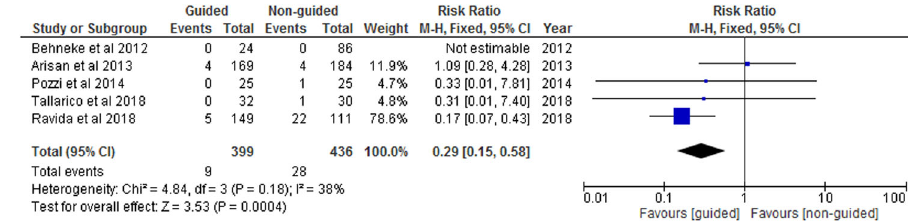
Fig. 2 Forest Plot. Forest plot comparing the “ guided ” group versus “ non-guided ” group for the event of implant failure.